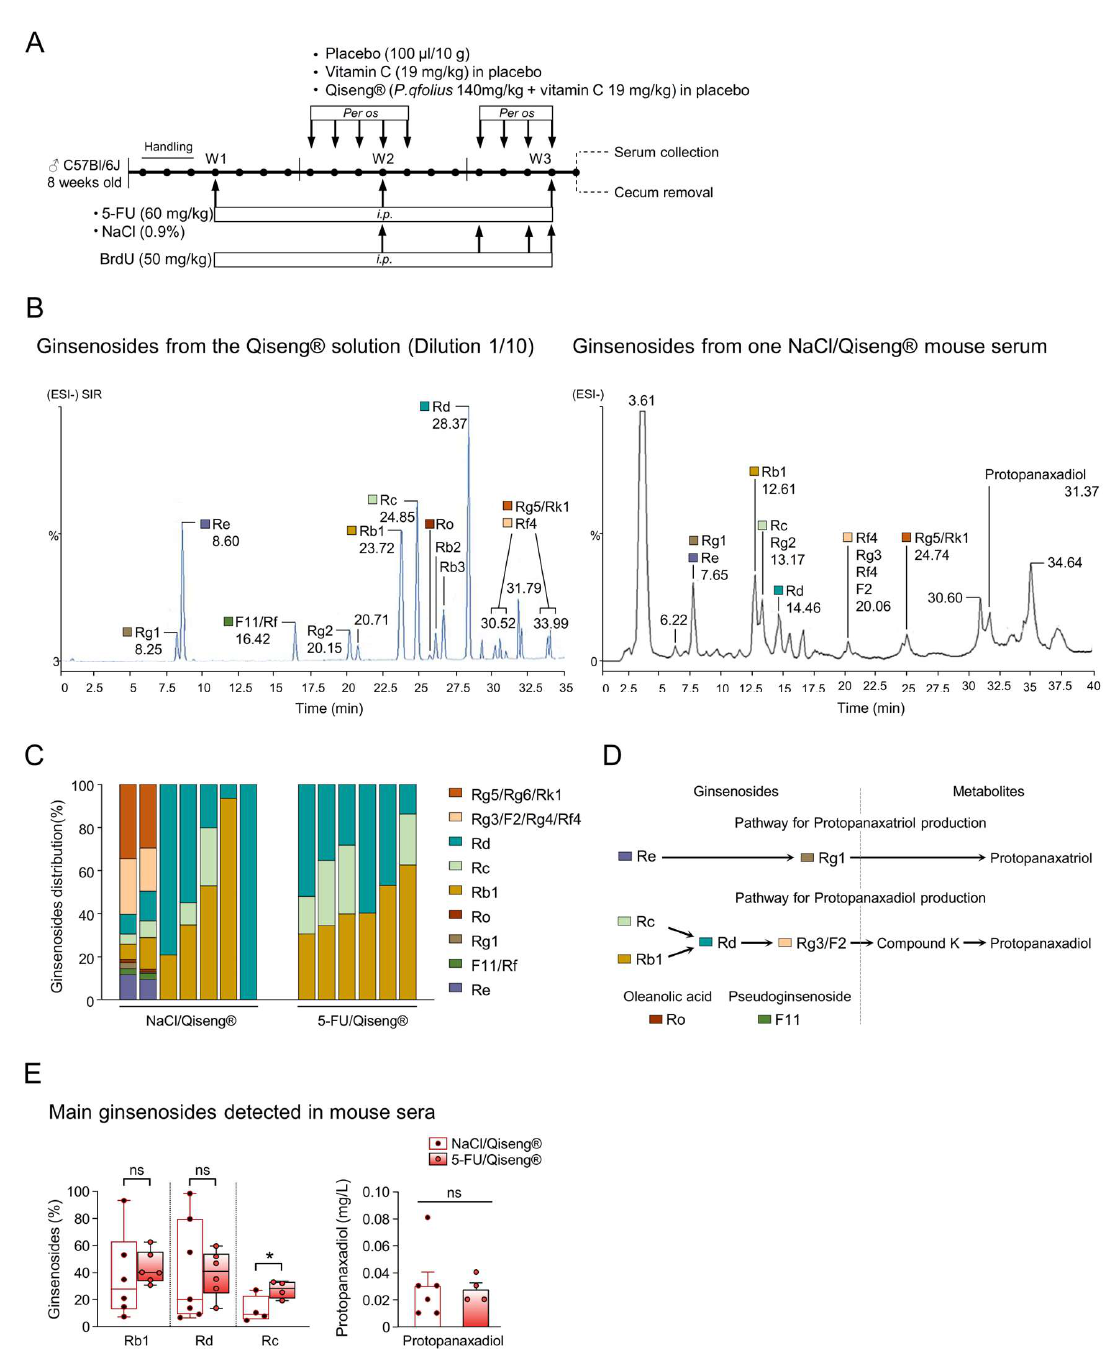
Figure 4. Detection of ginsenosides and protopanaxadiol in sera of placebo and 5-FU mice treated with Qiseng ® . ( A ) Schematic illustration showing the timeline for treatments and time of serum collection in mice to study the composition in ginsenosides and potential metabolites. C57BL/6J Rj mice received i.p. 5-FU injections once a week for 3 weeks ( arrow ) and per os placebo, vitamin C or Qiseng ® once a day, 5 times a week for 2 weeks. Mice received four BrdU i.p. injections (once a day) at W2 and W3; then, serum and cecum were collected for analysis. ( B ) HPLC chromatogram and chemoprofile of Qiseng ® and some ginsenosides from a 1/10 Qiseng diluted solution ( Left ) and from a representative example of a NaCl/Qiseng ® -treated mouse serum ( Right ). ( C ) Relative abundance of Rb1, Rc, Rd, Re, Rg5/Rg6/Rk1, Rg3/F2/RG4/Rf4, Ro, Rg1, F11/Rf ginsenosides in sera of NaCl/Qiseng ® and 5-FU/Qiseng ® -treated mice. The Rb1, Rd and Rc ginsenosides were predominantly found in sera of both groups, and the Rc ginsenosides proportion was significantly higher in 5-FU/Qiseng ® mice. ( D ) Schematic illustration of the composition of Qiseng ® and the potential me- tabolization by gut microbiota into protopanatriol, protopanaxadiol and Factor K metabolites ( Left ). Sole protopanaxadiol can be detected in only some serum collected from NaCl/Qiseng ® and 5-